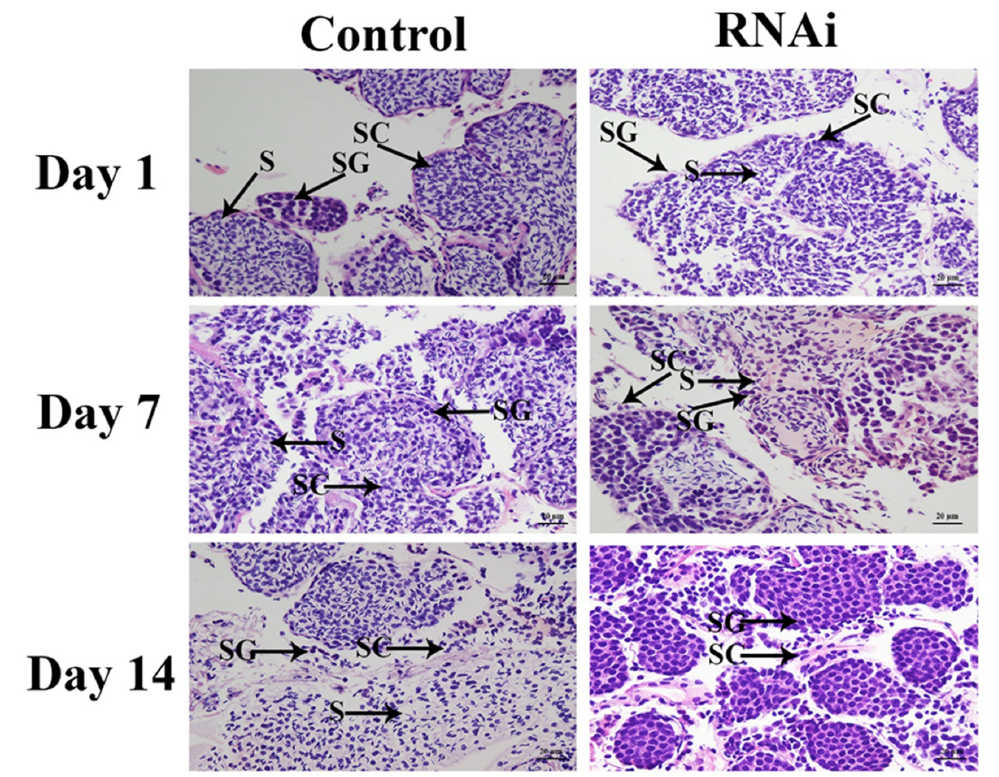
Figure 8. Histological comparison of testis tissue between dsGFP - and dsCycB -treated prawns. SG: spermatogonia; SC: spermatocyte; S: sperm. Scale bar = 20 μ m.